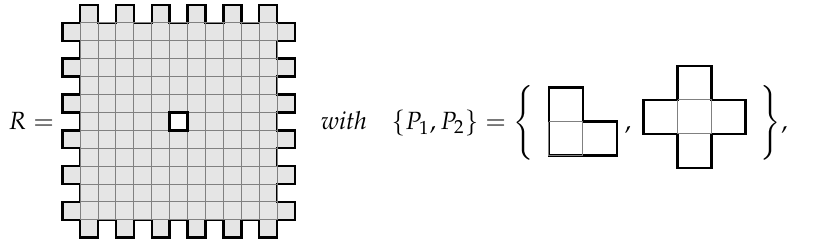
( = P − ), coloured light-blue, 1 1